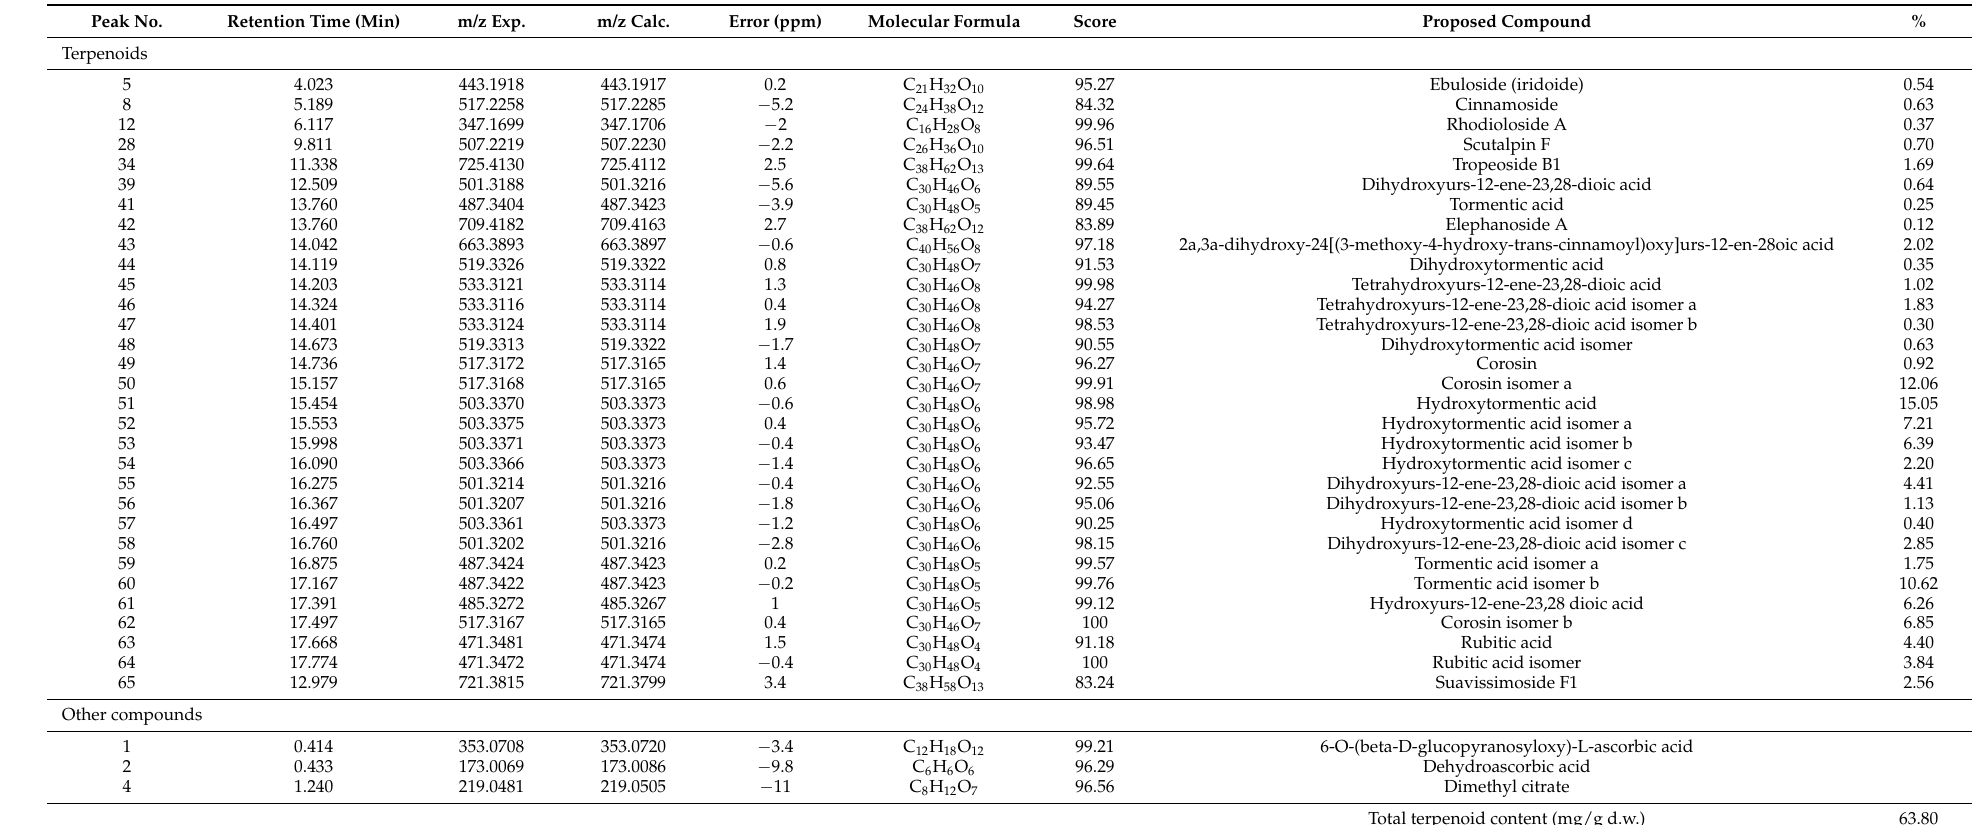
Table 2. Terpenes and other polar compounds identified in blackberry fruit